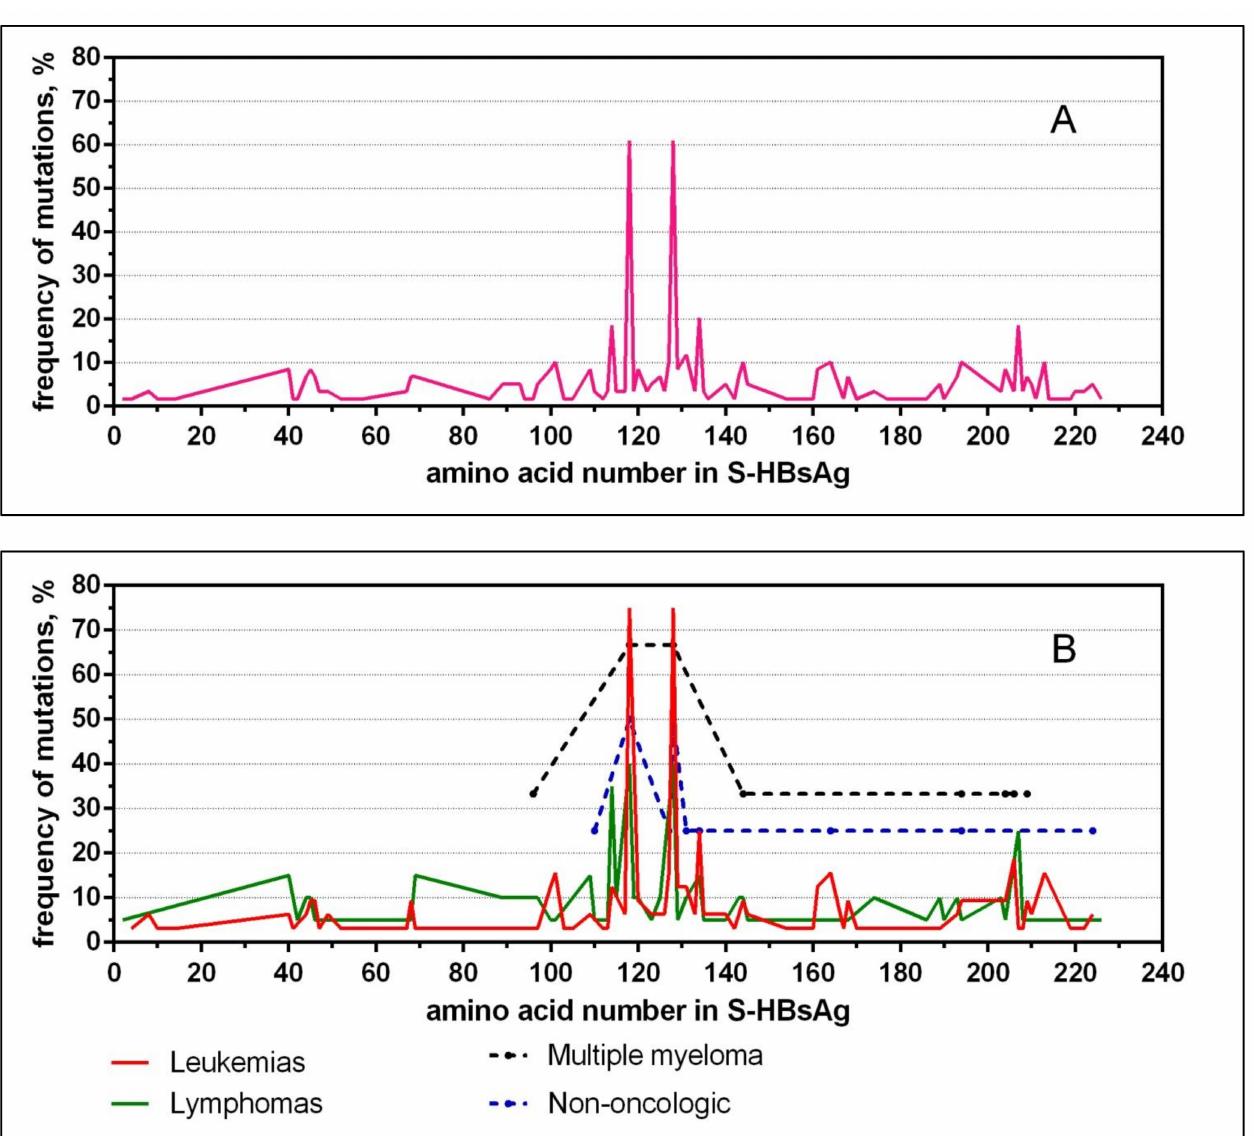
Figure 1. Mutation profile of S-HBsAg in patients with hematologic diseases. ( A )—for all studied groups, ( B )—for different hematologic